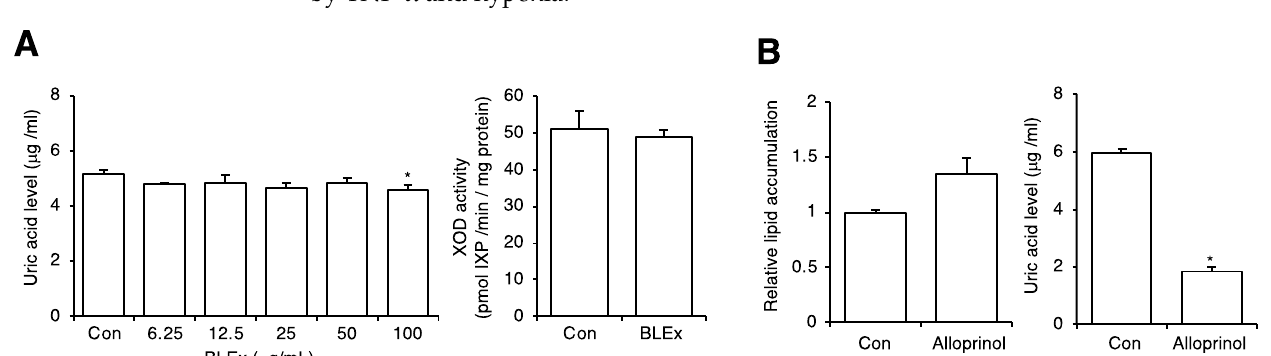
Figure 5. Effect of BLEx on the uric acid production of 3T3-L1 adipocytes. Data are means ± SE for 3 independent experiments. Statistical analysis was performed using one-way analysis of variance (ANOVA) and post hoc tests (Tukey–Kramer multiple comparisons) in the effect of BLEx on uric acid (most left panel) or Student’s t-test (other 3 panels). Asterisks indicate significant differences compared to the control at p < 0.05. ( A ): Effect of BLEx on uric acid release into the media and cellular XOD activity. ( B ): Effect of allopurinol, an inhibitor of XOD, on the lipid accumulation (Oil Red O staining) and uric acid release into the media.